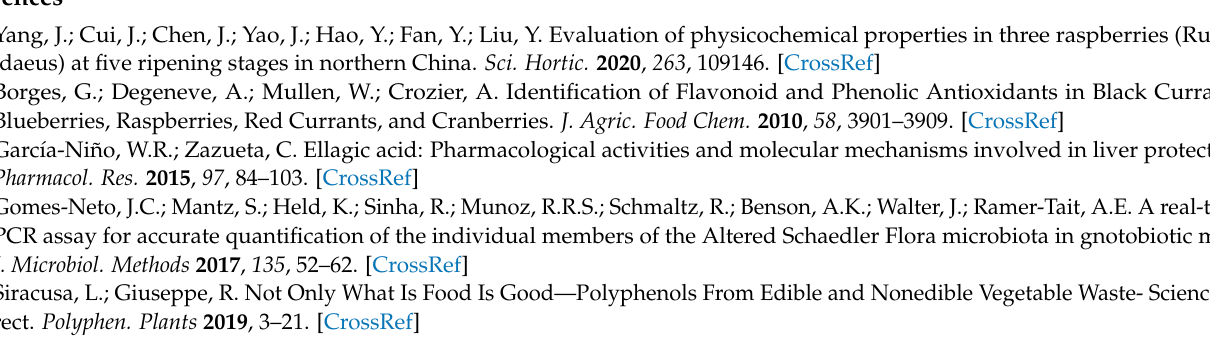
doses., Table S1: Compositions of the standard diet AIN93, Table S2: Primers of gut microbiota used in this study, Table S3: Primers of related genes used in this study, Table S4: Changes of total number of L.casei colonies and pH of NFRJ/FRJ, Table S5: Organ index of mice in each